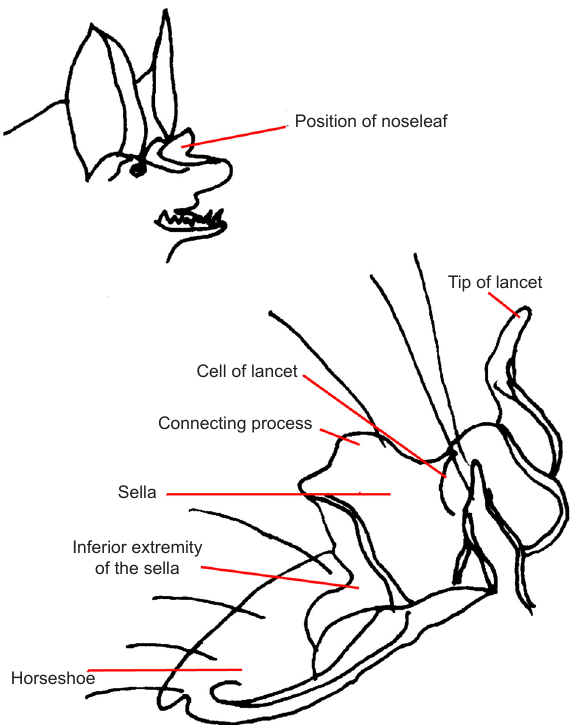
Figure 6. Lateral view of noseleaf of Rhinolophus sinicus